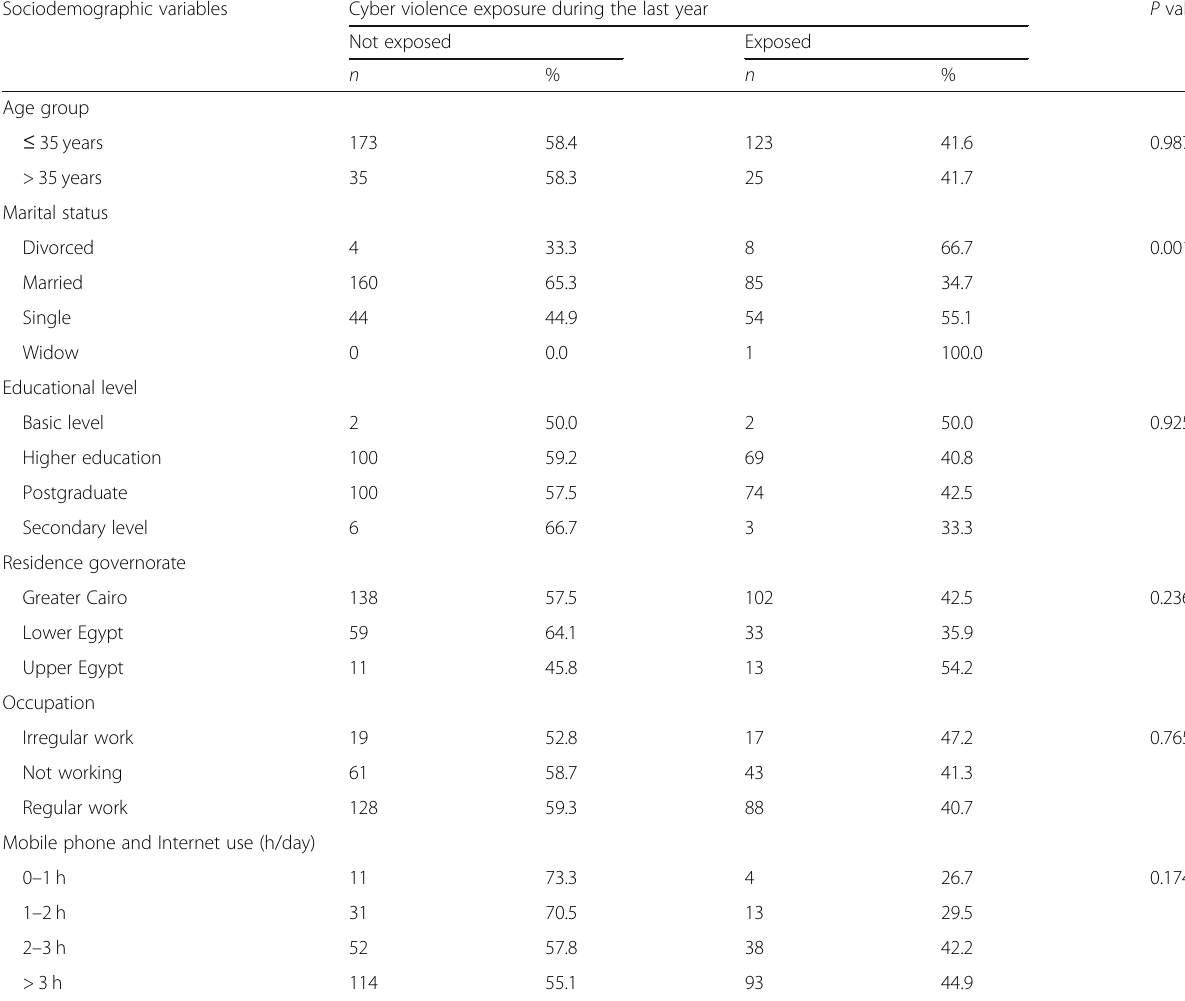
Table 5 Relation between sociodemographic data and cyber violence exposure among participating females during the last year ( N = 148) Sociodemographic variables